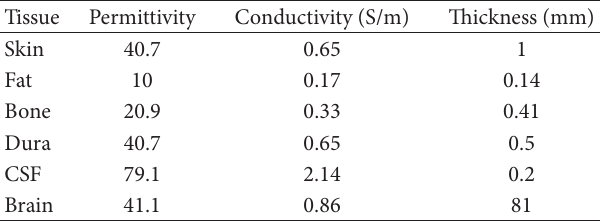
T 3: Tissue properties and thickness of six-layer human head model